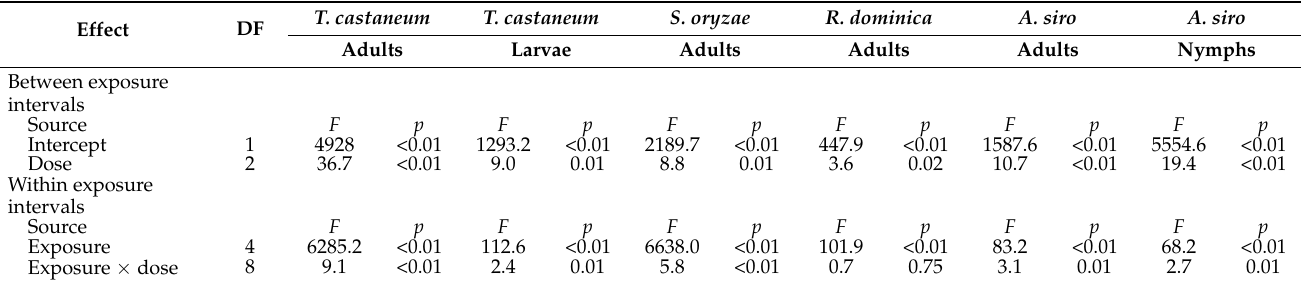
Table 1. MANOVA parameters for main effects and associated interaction for mortality of Tribolim castaneum adults and larvae, Sitophilus oryzae adults, Rhyzopertha dominica adults, and Acarus siro adults and nymphs between and within exposure intervals (error DF =